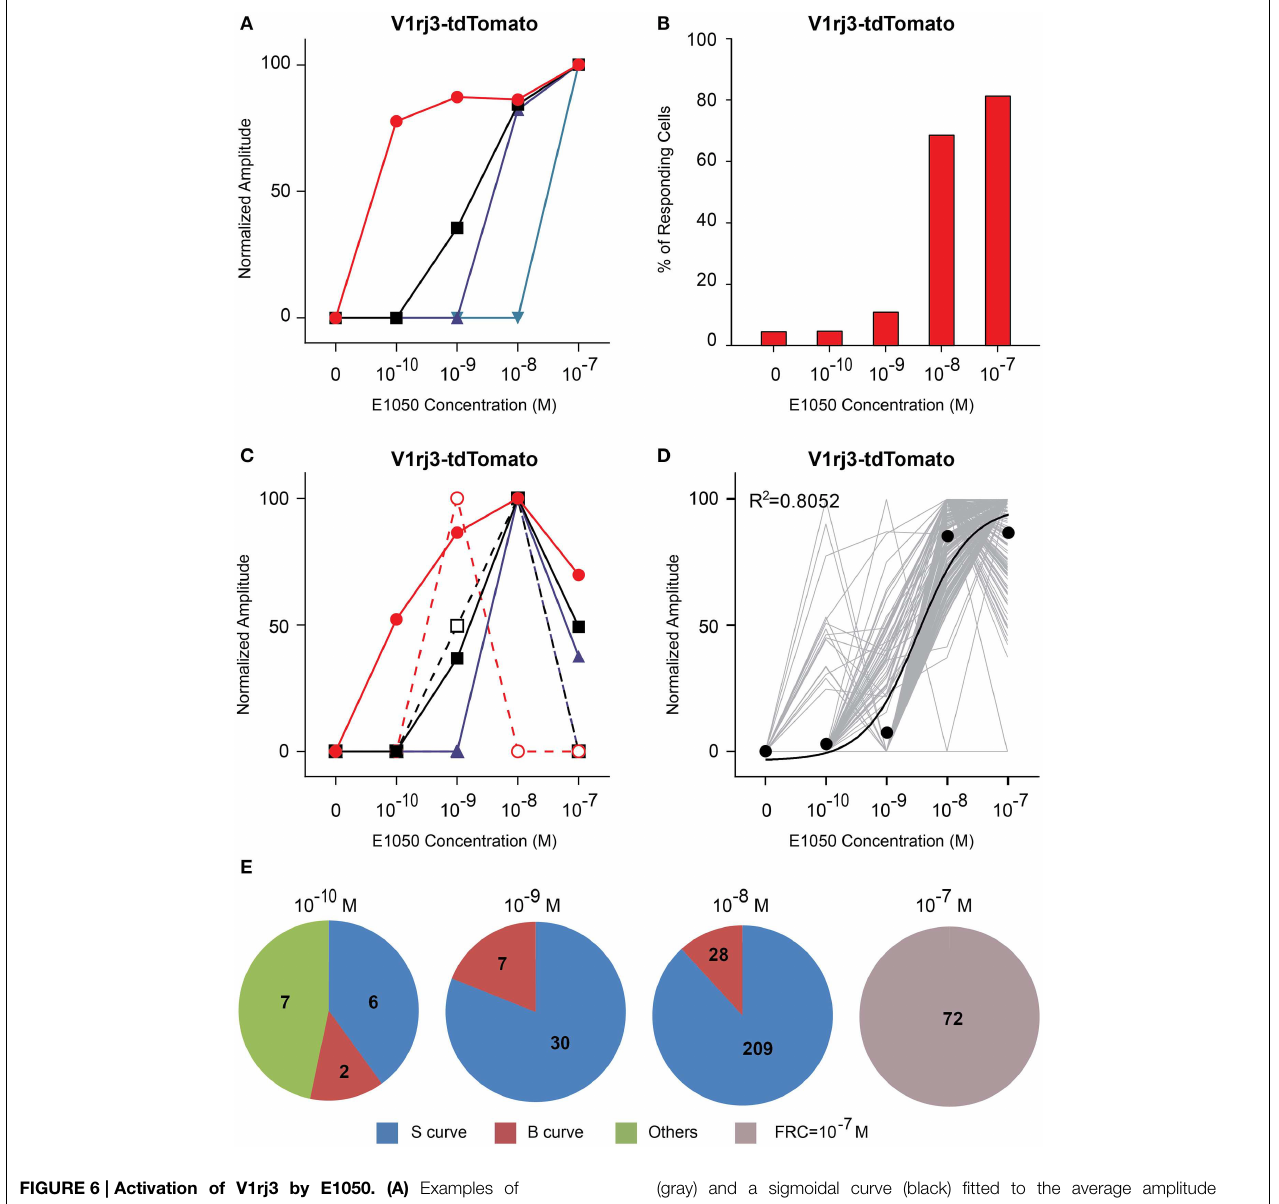
FIGURE 6 | Activation of V1rj3 by E1050. (A) Examples of sigmoidal dose-response curves to E1050 in V1rj3 cells. (B) Bar graph showing the percentage of E1050 activated V1rj3 cells ( n = 256 ). (C) Examples of bell-shaped dose-dependent responses of V1rj3 cells to E1050. (D) Dose-response curves of individual cells